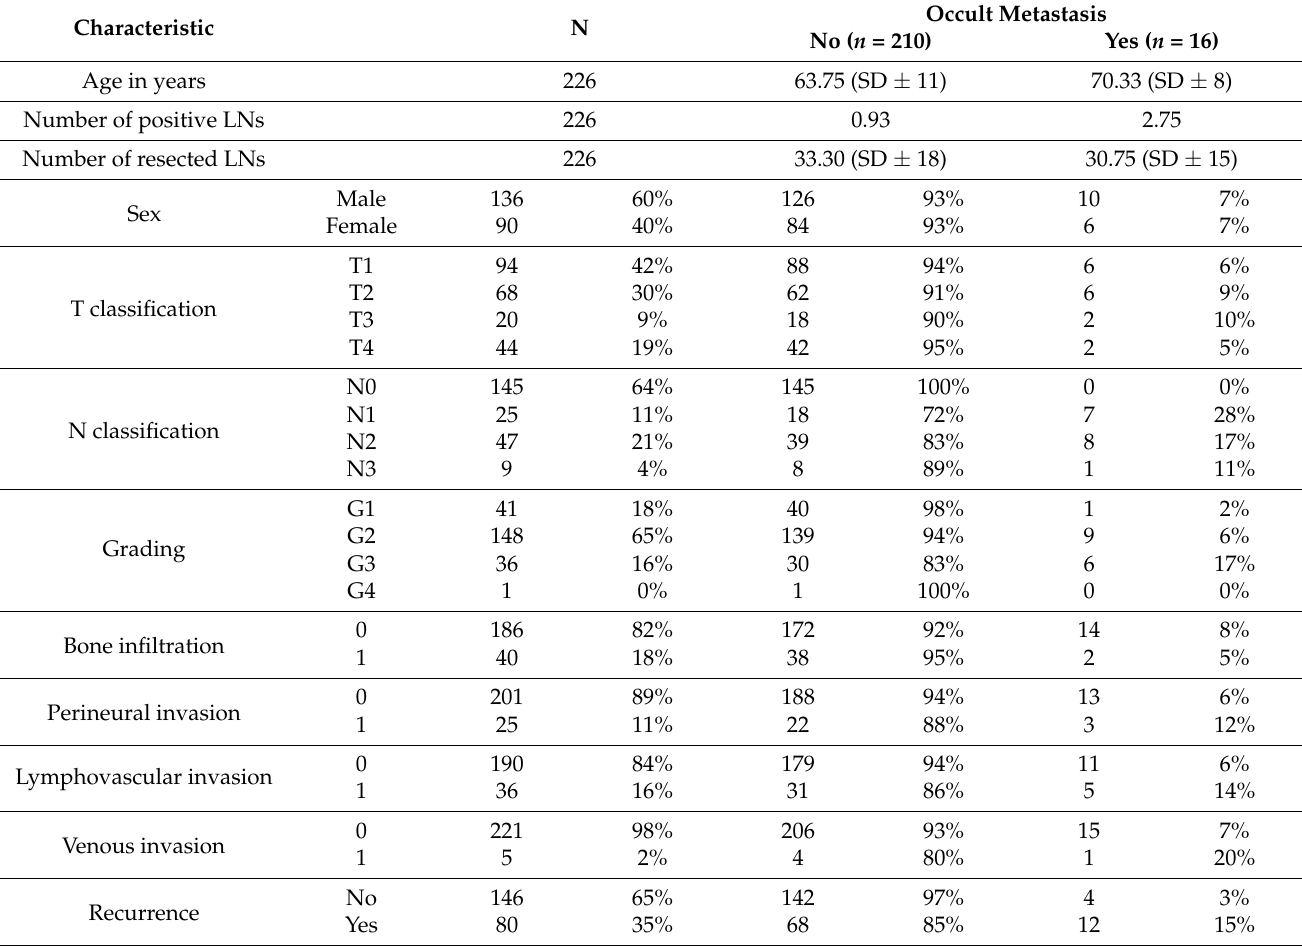
Table 1. Patient characteristics.